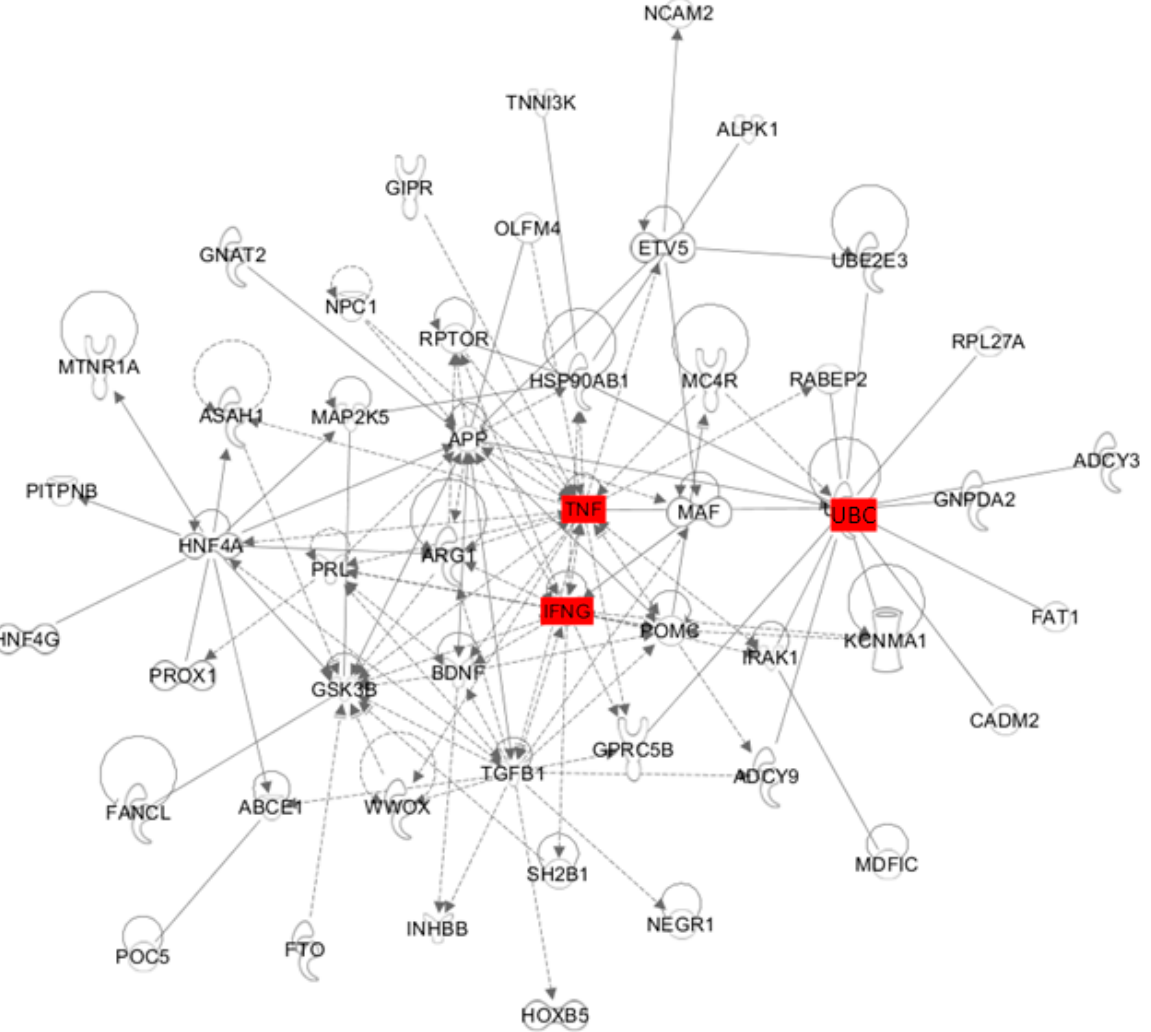
Figure 5. Interconnected gene networks between IFN γ and the most significant obesity-related variants. The most significant 55 variants were selected by the National Human Genome Research Institute GWAS catalog ( p ≤ 1 × 10 − 5 ). TNFA and UBC were identified by explorative analysis in IPA. Solid and dashed lines indicate direct and indirect interactions, respectively.